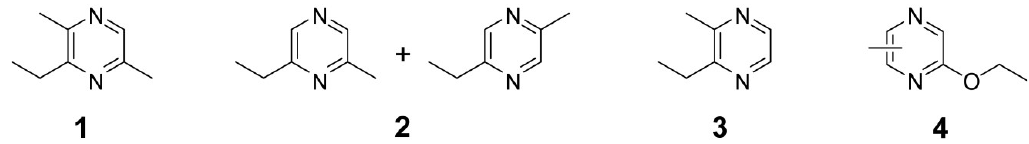
Figure 1. Chemical structures of pyrazines. 1 , 2-ethyl-3,6-dimethylpyrazine (EDMP); 2 , 2-ethyl-5(6)-methylpyrazine ((EMP) (2-ethyl-6-methylpyrazine (2E6MP) + 2-ethyl-5-methylpyrazine (2E5MP))); 3 , 2-ethyl-3-methylpyrazine; 4 , 2-methyl-3(5 or 6)-ethoxypyrazine (MEOP).